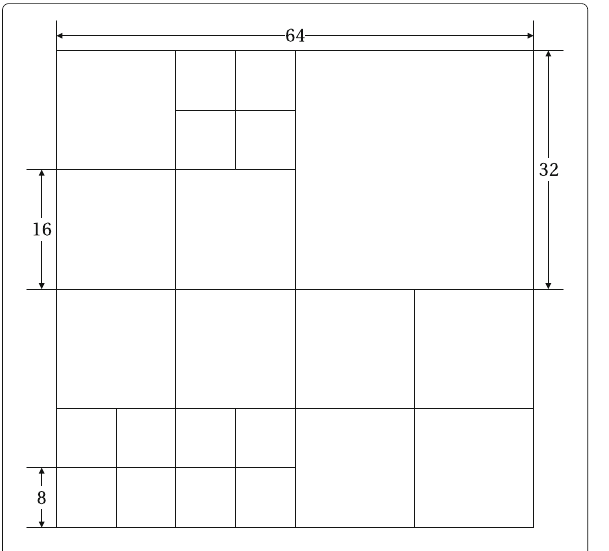
Fig. 2 Intra-prediction modes of a luma PU